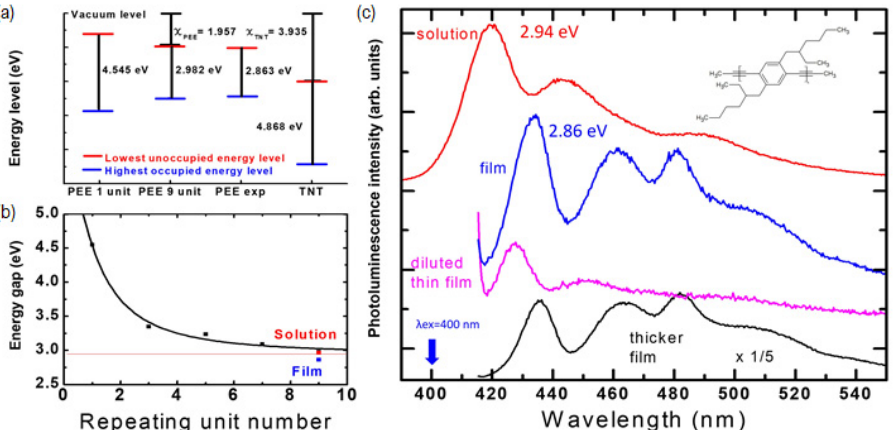
Figure 2. ( a ) The HOMO and LUMO energy levels of PEE and TNT. Calculations were done with the Orca ab-initio calculation package with the DFT-B3LYP/6-31G level of theory. ( b ) Energy gap as a function of the number of PEE monomer repeating units. Red and blue dots are the experimentally observed PL peak energies in solution and in film, respectively. ( c ) PL spectra of PEE in toluene solution phase (red), film phase (blue), thin film phase (magenta), and thicker film phase (black). The molecular structure of PEE is shown in the